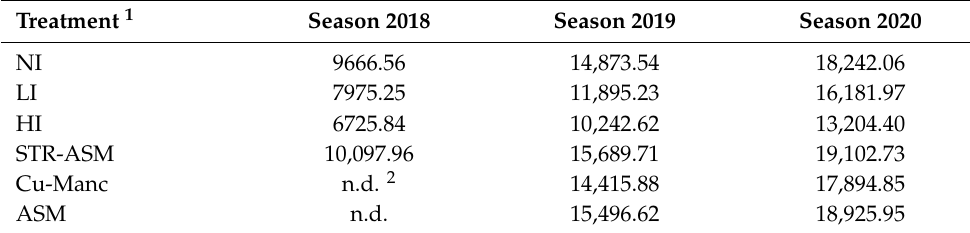
Table 3. Average tomato harvesting and marketing costs in USD/ha.